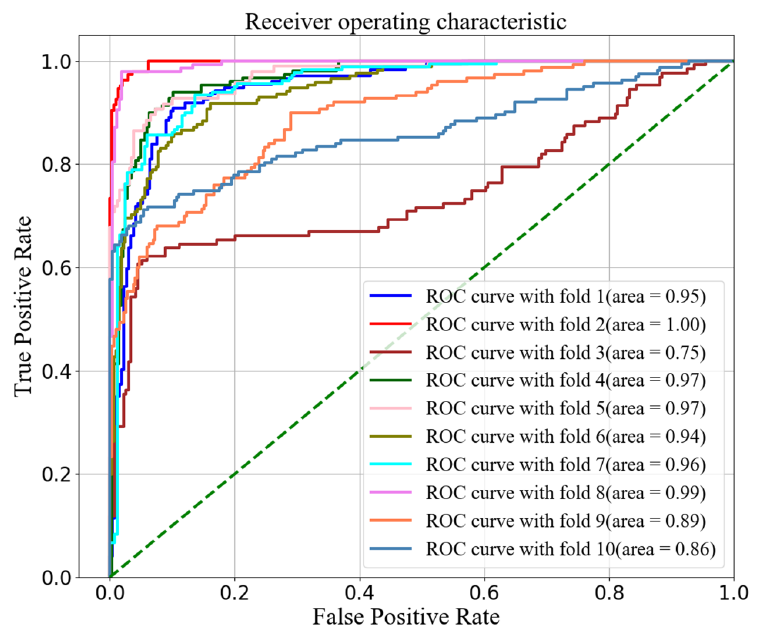
Figure 6. The ROC curve of 10 folds with 2000 sample